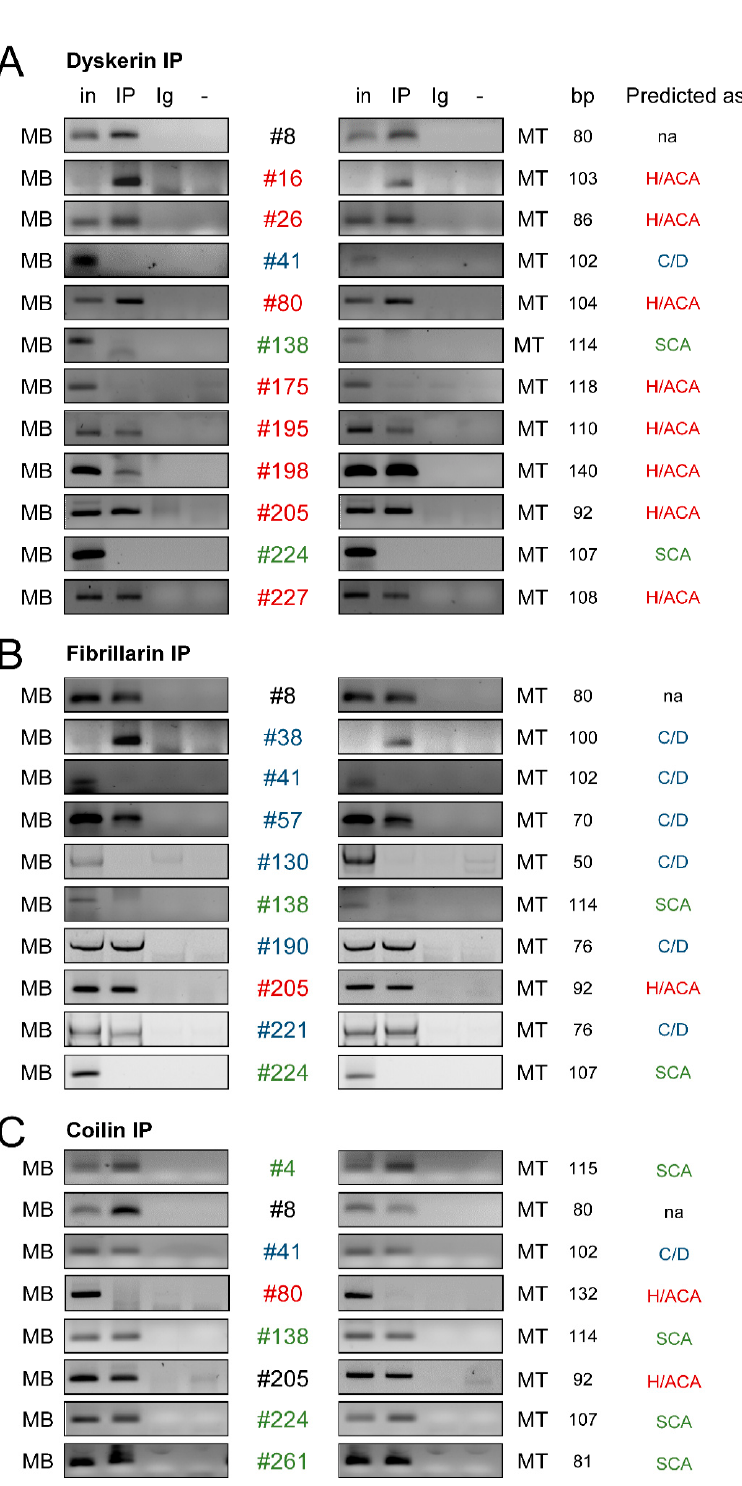
Figure 2. Association of snoRNA candidates with sno-ribonucleoprotein (snoRNP) complexes. IP-PCR against Dyskerin ( A ), Fibrillarin ( B ) and Coilin ( C ) was performed as described in the Material and Methods section to analyze the affiliation of the new snoRNA candidates (#) to their respective snoRNP complexes (n = 2). The class of snoRNA (H/ACA, C/D or SCA) predicted by the webservers is indicated on the right. MB, myoblast; MT, myotube; in, 5% input; IP, immunoprecipitation; Ig, V5 epitope antibody (irrelevant antibody); -, mock PCR; bp, base